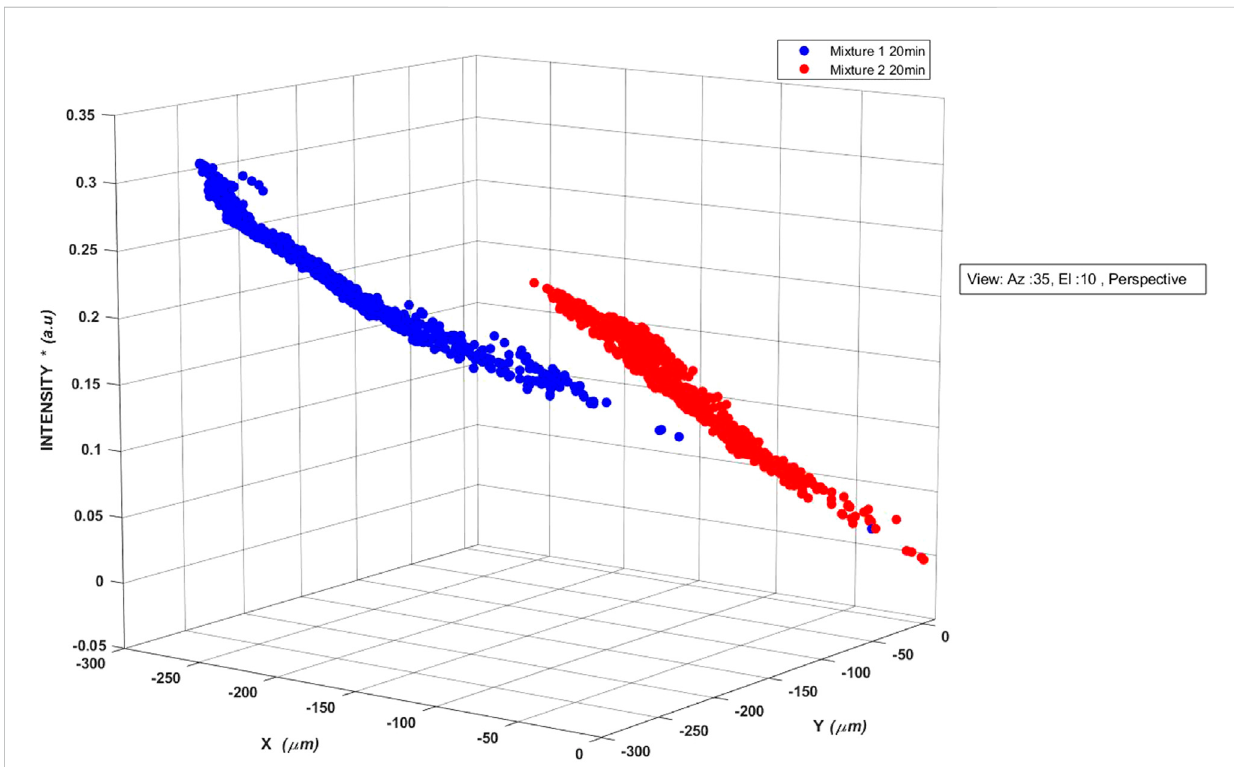
Three-dimensional scatter plots of backscattered light detected by the photodetector of AUM photonic system when aerosols laden with different bacterialmixtureswereinjectedintotheinterrogationvolumeoflightscattering. Themultiplicationfactorof10 – 7 inthenormalizedintensity valuesisnot shown. The superposed 3D backscattered data indicate that backscattered data pertaining to the two different microbial mixtures of species still occupy unique Euclidian space but raises questions regarding resolvability into their constituent individual microbial species. Therefore, the need for appropriate models for resolving the mixture scatter into different individual species present in the mixture.